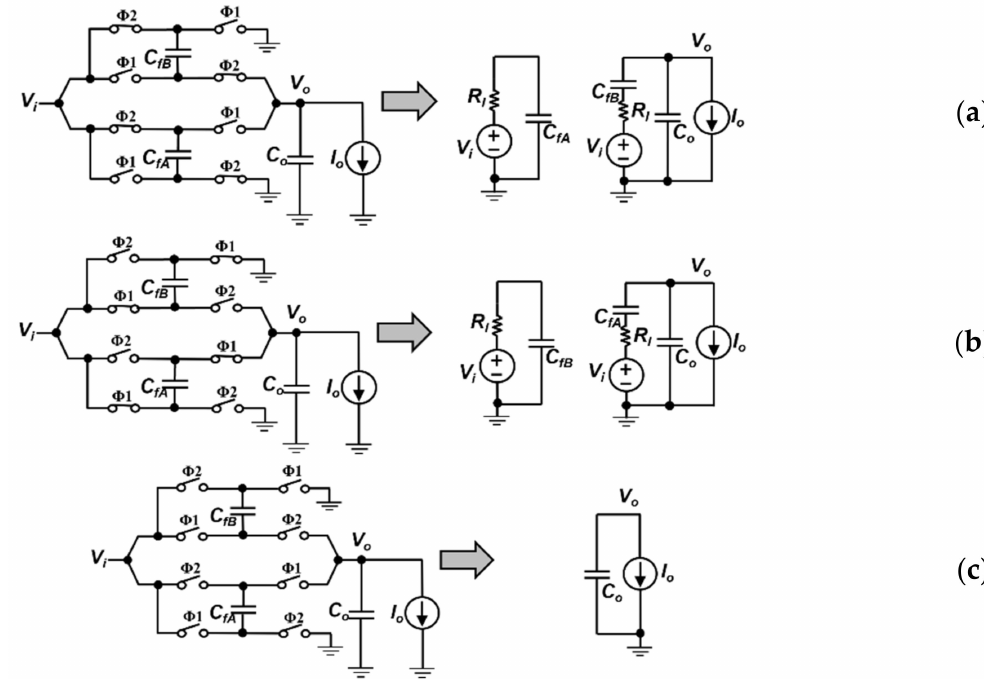
Figure 6. Switching of dual-branch 1-stage linear charge pump/cross-coupled voltage doubler ( a ) Φ 1 = 1; Φ 2 = 0 ( b ) Φ 1 = 0; Φ 2 = 1 ( c ) Φ 1 = 0; Φ 2 = 0 (i.e.,